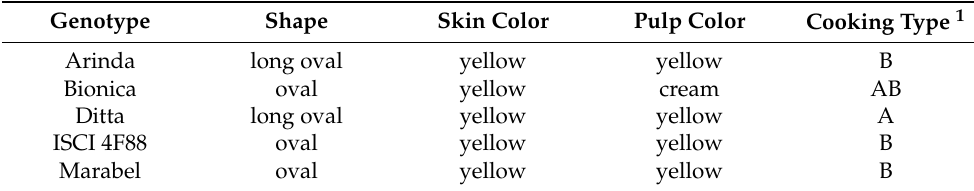
Table 1. Main tuber characteristics of the five genotypes under study. Genotype Shape Skin Color Pulp Color Cooking Type 1 Arinda long oval yellow yellow B Bionica oval yellow